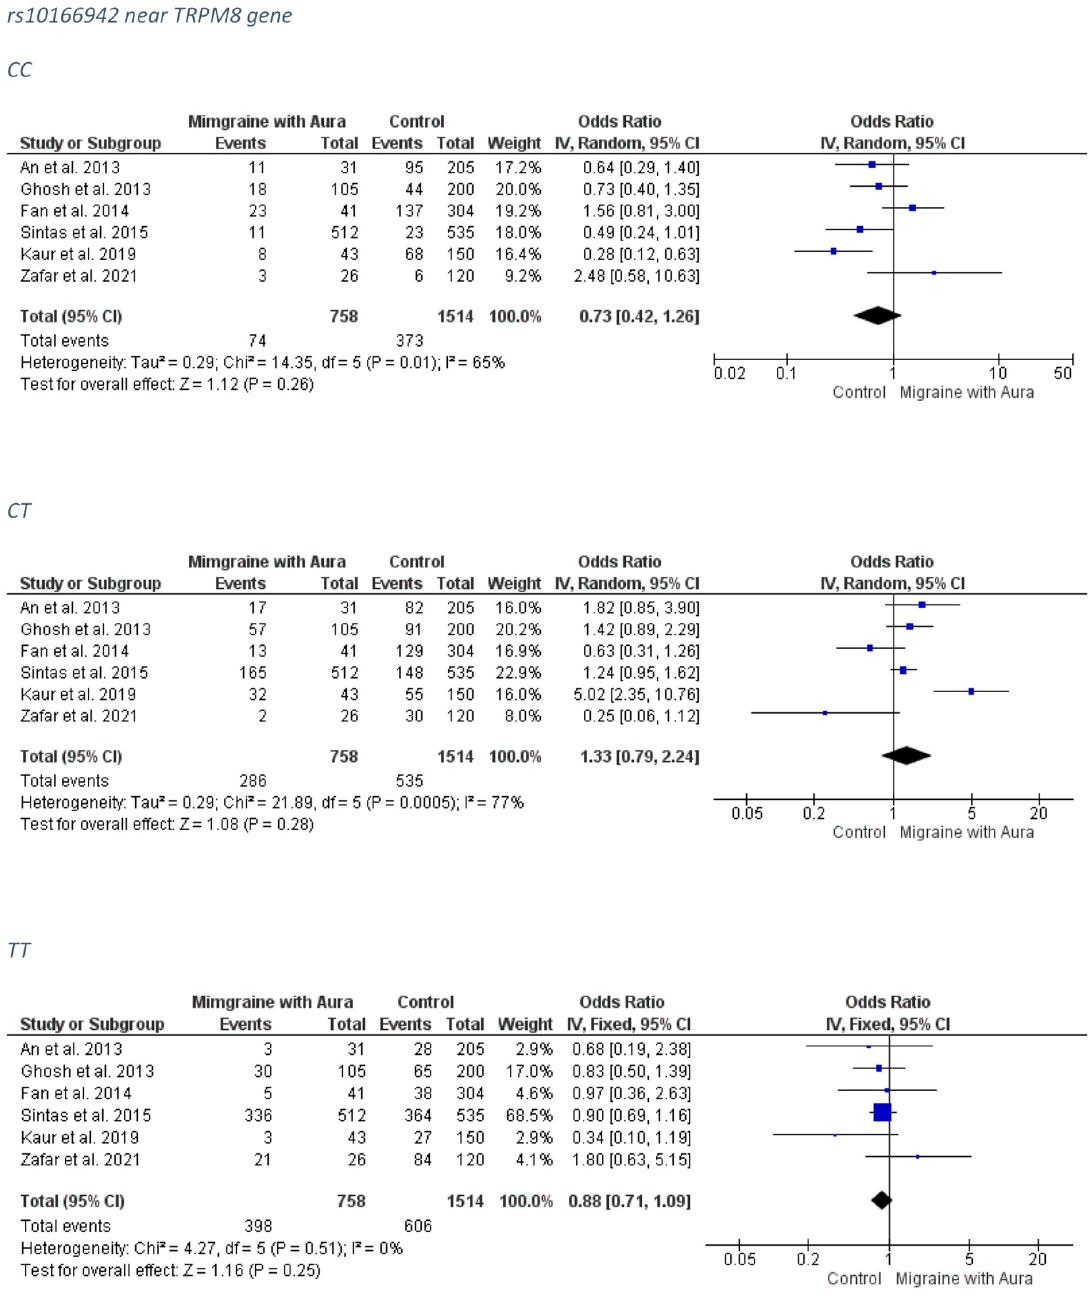
Figure 6. The forest plots presenting the results from meta-analysis of the rs10166942 and migraine without aura group .